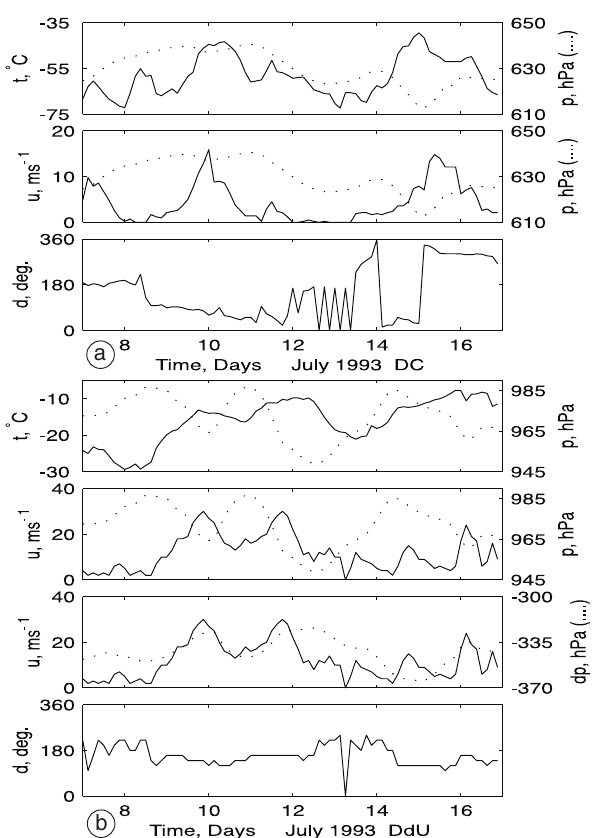
Fig. 6a,b. Time series of meteorological parameters: a) for Dome C showing strong wind events around 10 and 15 July 1993; b) for Dumont d’Urville depicting strong wind events around 10 and 12 July 1993,